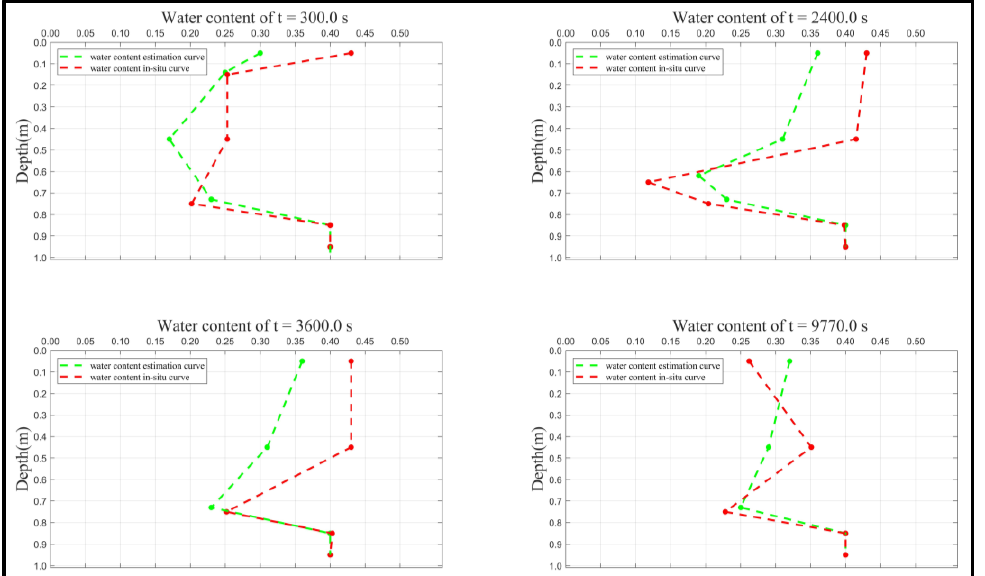
Figure 15. The estimated and measured water content at four different injection times (Author’s own work) [56].